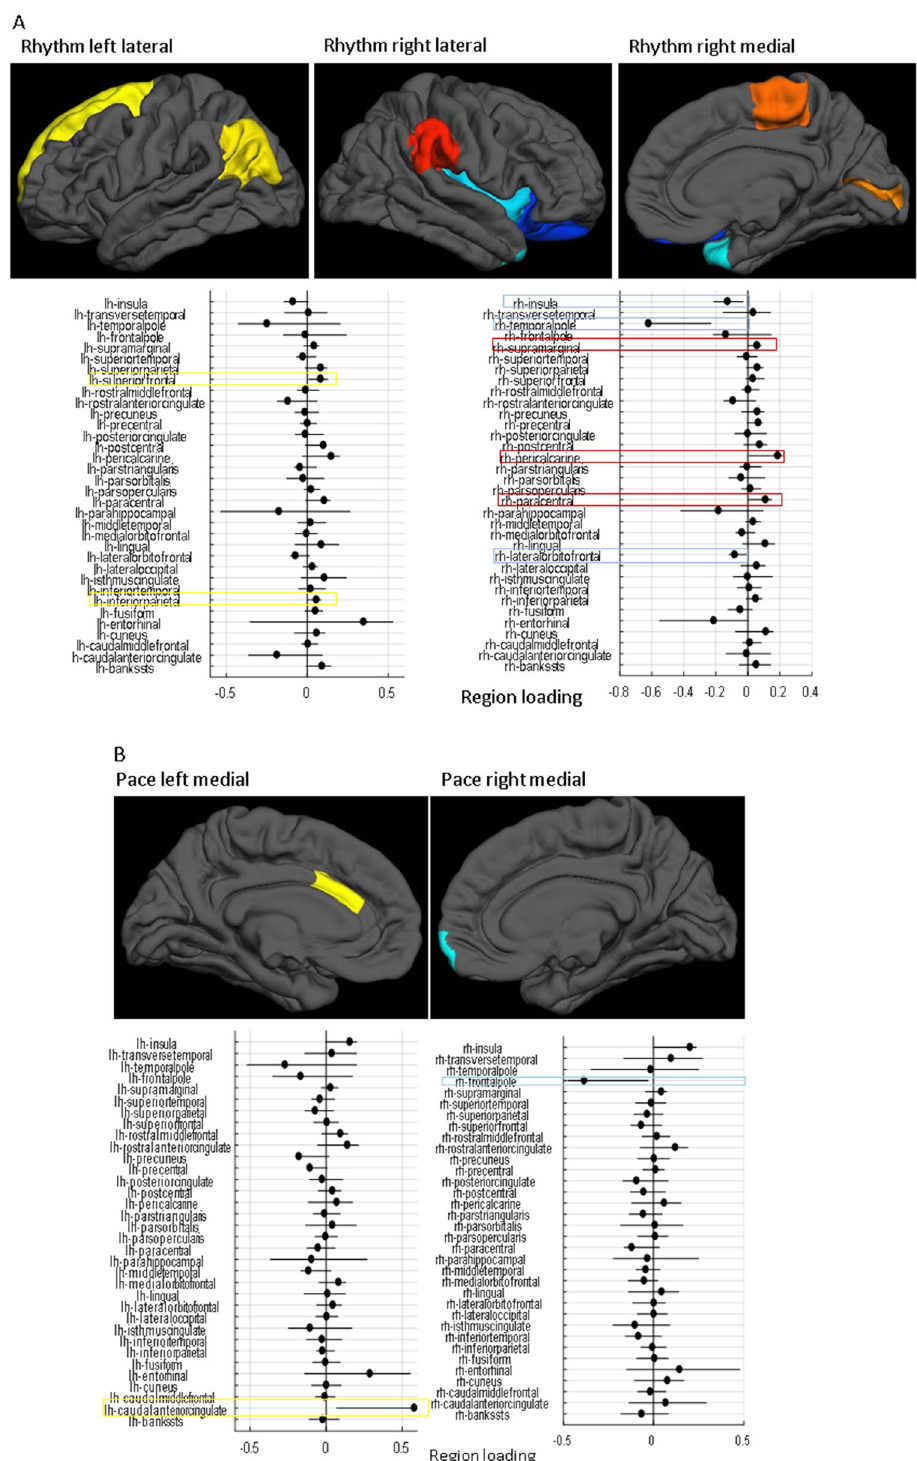
Figure 2. The loading of each brain region in the linear combination of PCs that best fit each of the mobility variables. The top surface plots show regions that were deemed robust in the bootstrap procedure, with hot colors (red shades) indicating positive loadings, and cold colors (blue shades) indicating negative loadings according to the left bars (lh = left hemisphere, rh = right hemisphere). The horizontal line plots show point estimates for the loadings as black dots for each region and indicate the coverage interval [5‰ 95‰] of the 10,000 bootstrap iterations. ( A ) the cortical-thickness pattern constructed from PCs1–3, which is associated with usual-walking gait rhythm, ( B ) the cortical-thickness pattern constructed from PCs 1–6, which is associated with usual-walking gait pace, and ( C ) the specific brain regions constructed from PCs 1–2 which is associated with usual-walking gait symmetry. Positive loadings indicate a relatively thicker regional cortex with the gait measures, while negative loadings indicate a relatively thinner regional